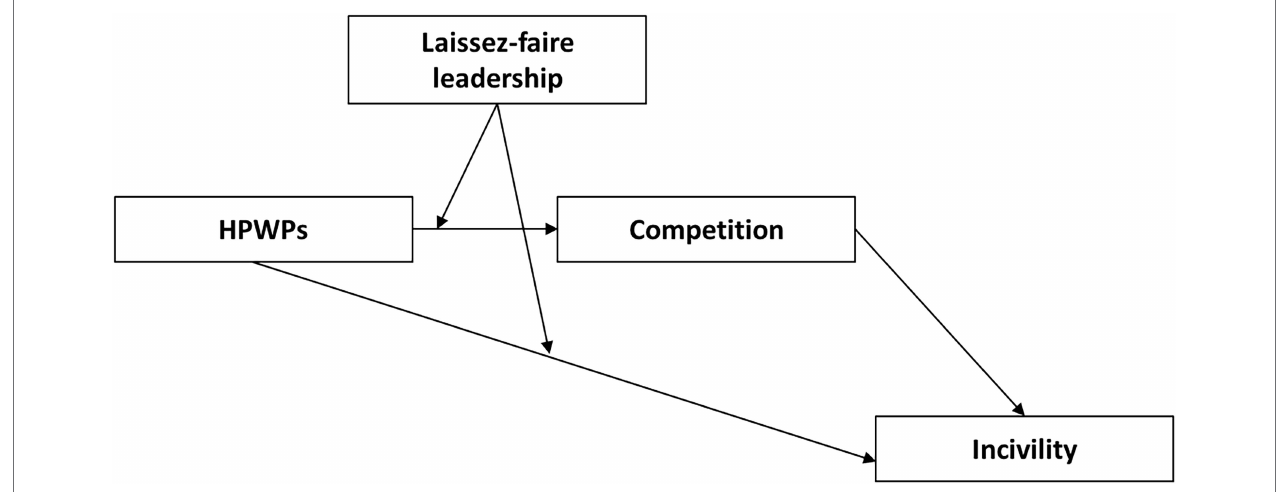
FIGURE 1 | Conceptual